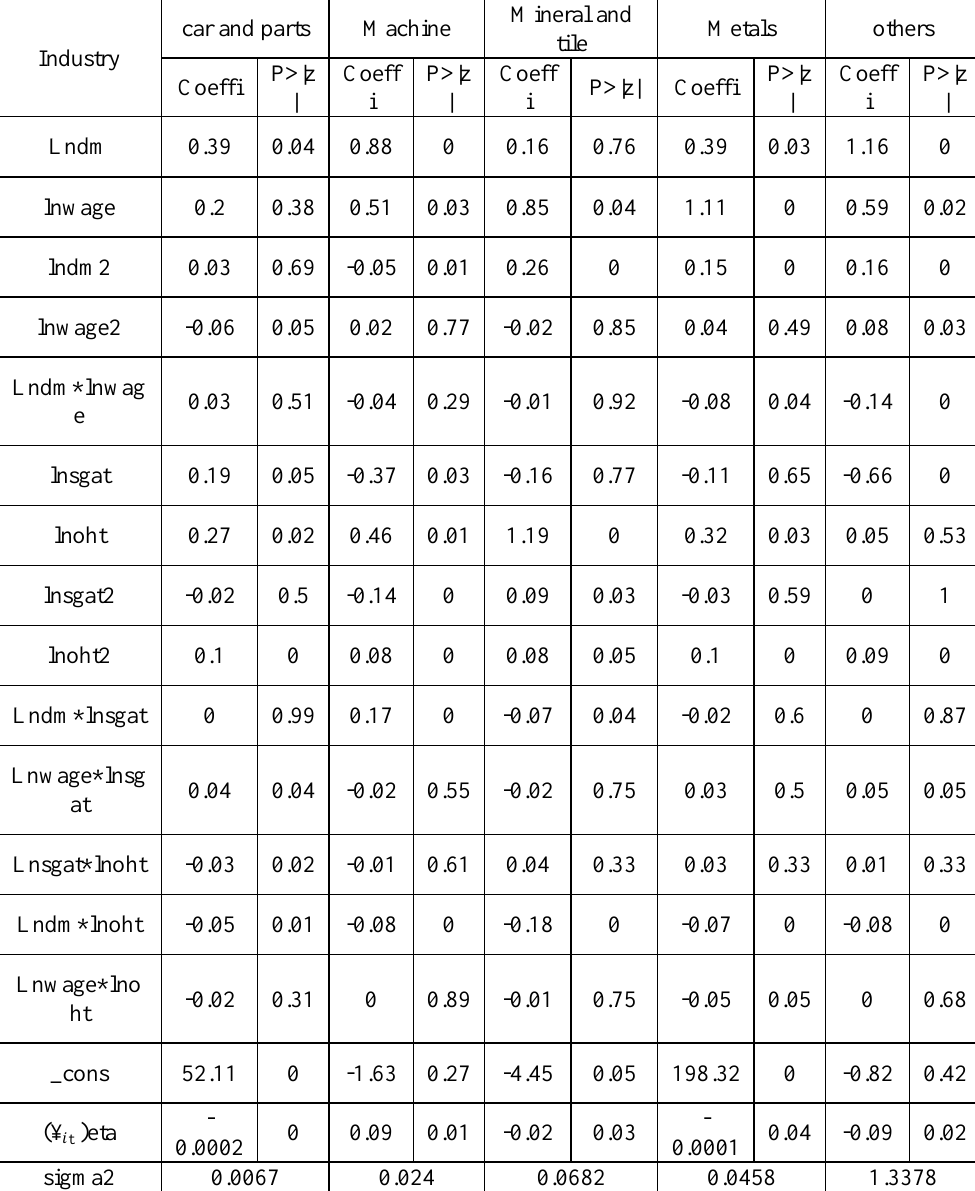
Table 4. Maximum likelihood estimation model